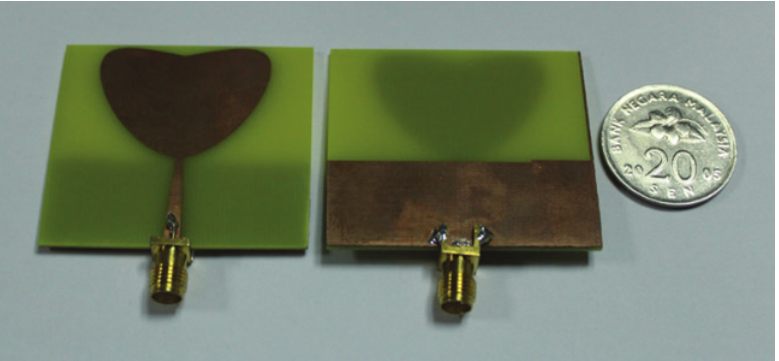
Figure 6: The photograph of the proposed SWB antenna prototype.